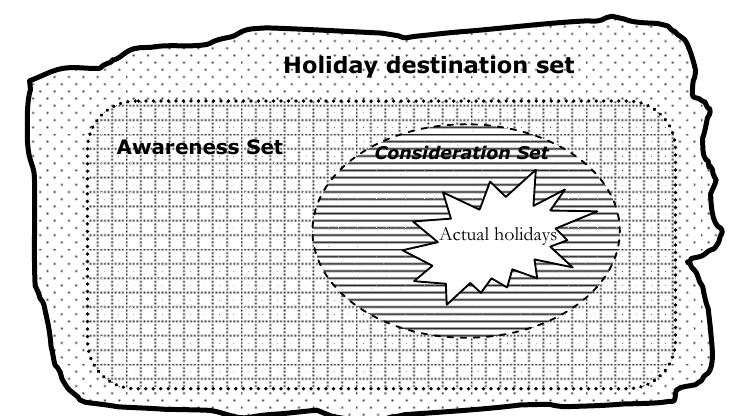
Graph 1 − Mapping of the tourism decision